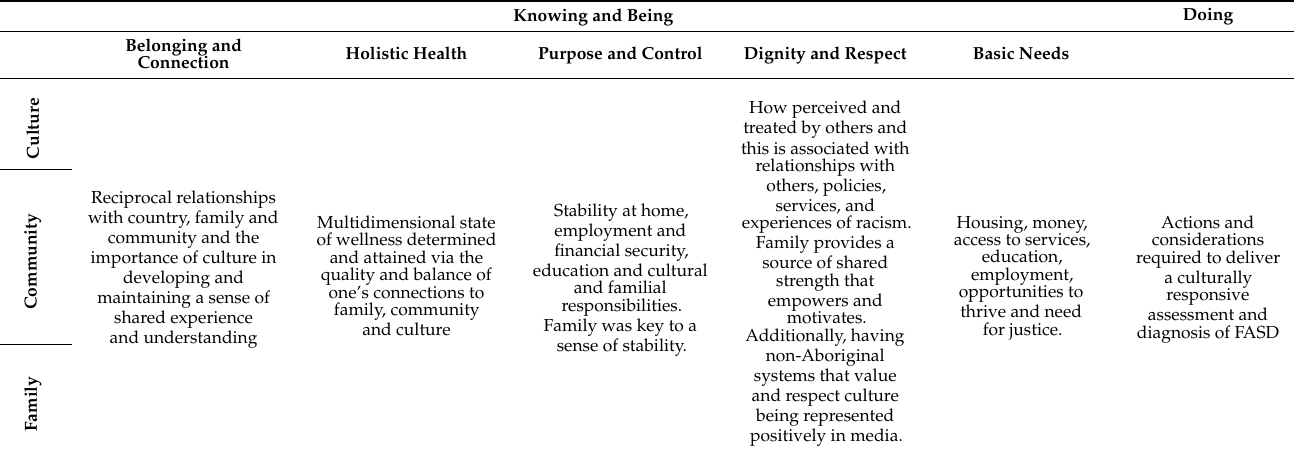
Table 1. Knowledge review mapping table integrating the knowing, being and doing principles of IAHA Culturally Responsive Framework and the dimensions of the Fabric of Aboriginal and Torres Strait Islander Wellbeing